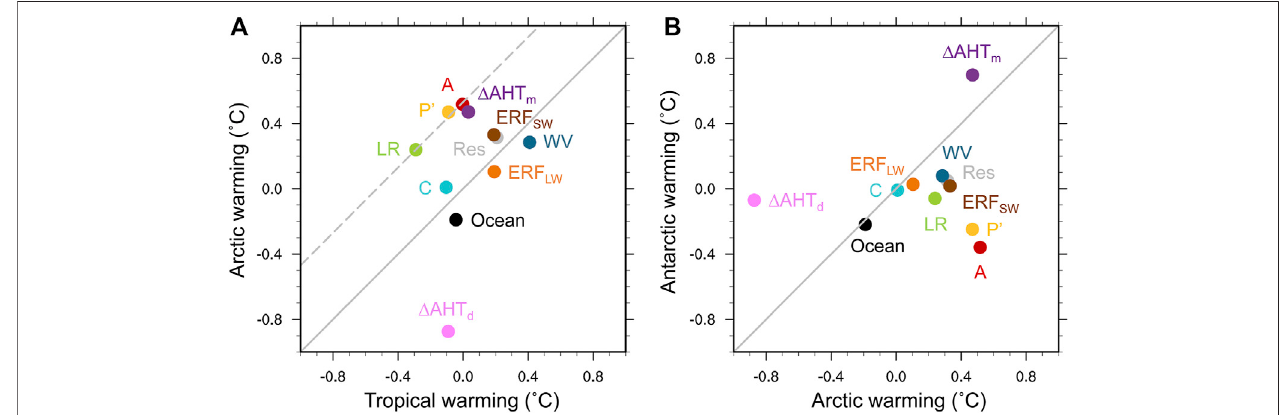
FIGURE 9 | Contributions to warming ( ˚ C) for 1979 – 2014 in AMIP6 models for (A) the tropics relative to the Arctic and (B) the Arctic relative to the Antarctic. Warming contributions are shown for the lapse-rate (LR), surface albedo (A), water-vapor (WV), and cloud (C) feedbacks, the variation in the Planck response from its global-meanvalue(P ’ ),longwaveandshortwaveeffectiveradiativeforcing(ERF LW ;ERF SW ),changeinmoistanddryAHTconvergence( Δ AHT m ; Δ AHT d )andoceanheat uptake (Ocean), and residual term (Res). Dashed grey line shows a 1-to-1 slope through the lapse-rate feedback warming contribution.